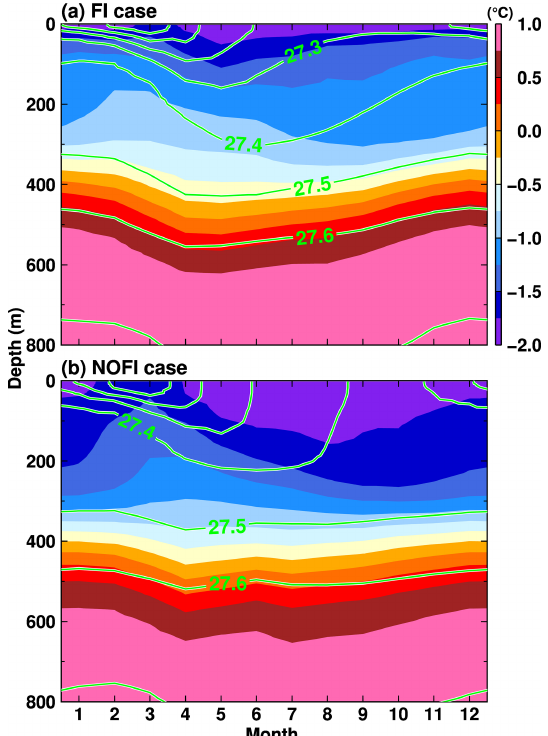
Figure 12. Seasonal variation in potential temperature (color) and potential density anomaly (green contours) averaged over the box area (Fig. 8) in the (a) FI and (b) NOFI cases. The variables were averaged over the period